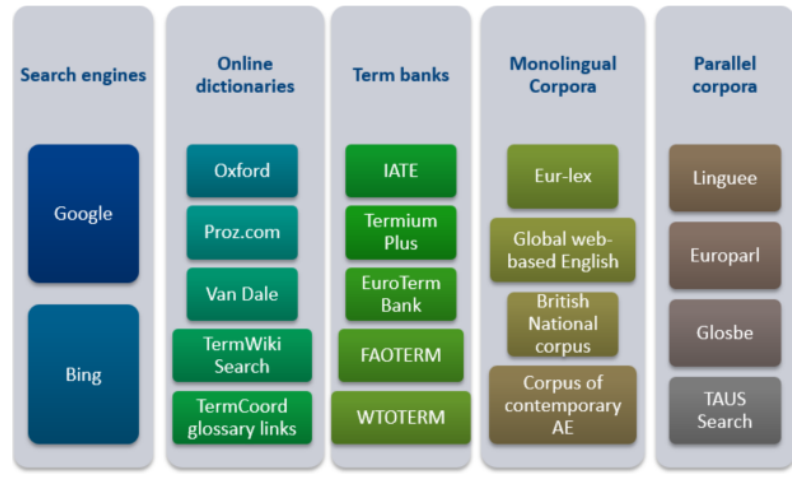
Figure 9. Most used online terminological